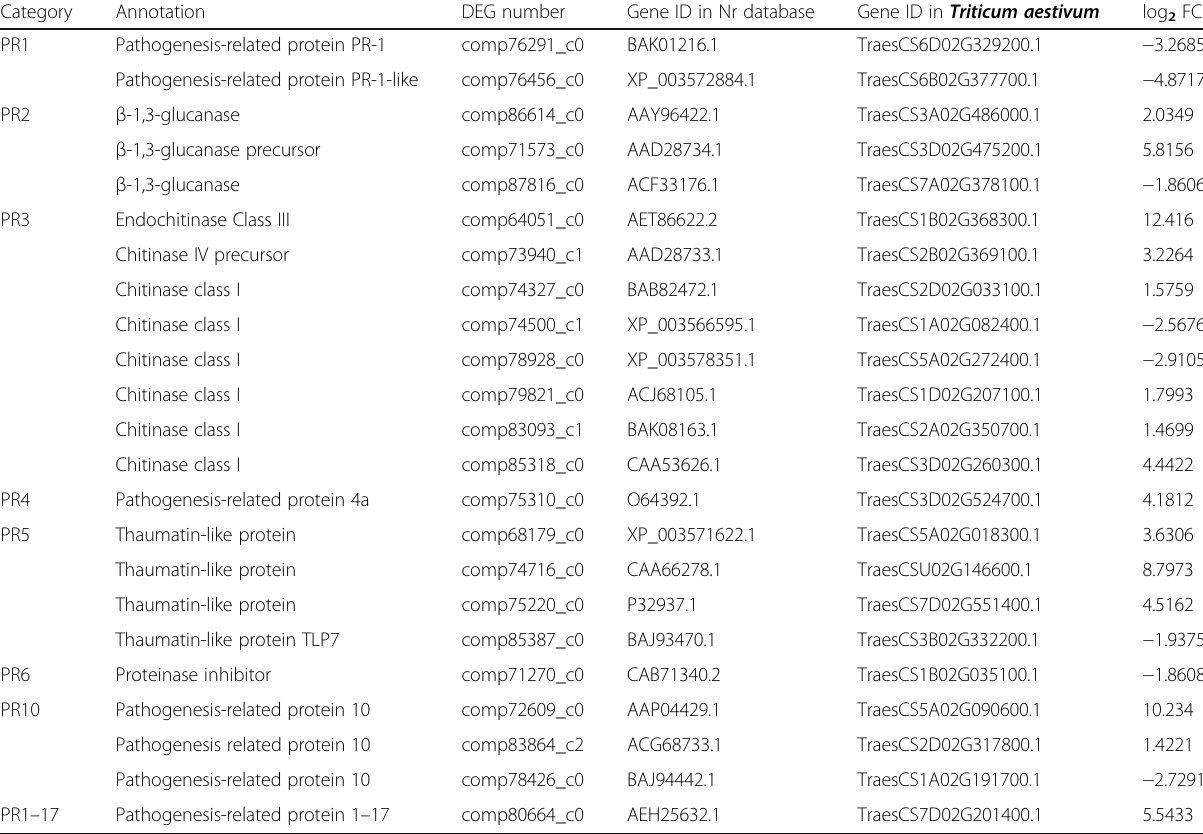
Table 2 DEGs for pathogenesis-related proteins